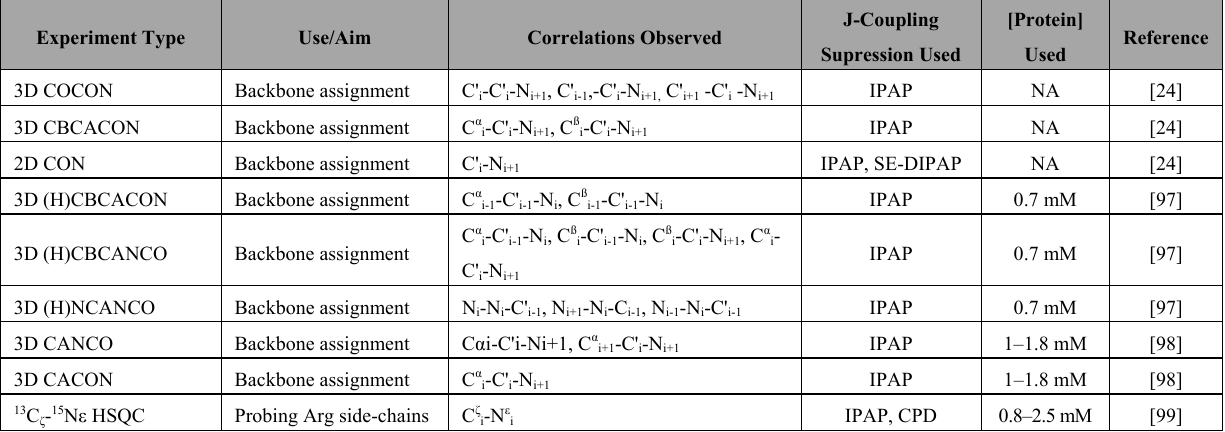
Table 1. Set of experiments described in the 13 C-detected NMR methodology. Only relevant correlations for the experimental aim are mentioned (NA, Non Available; IPAP, In-Phase Anti-Phase; SE-DIPAP, Storage Element Double In-Phase Anti-Phase; CPD, Composite Pulse